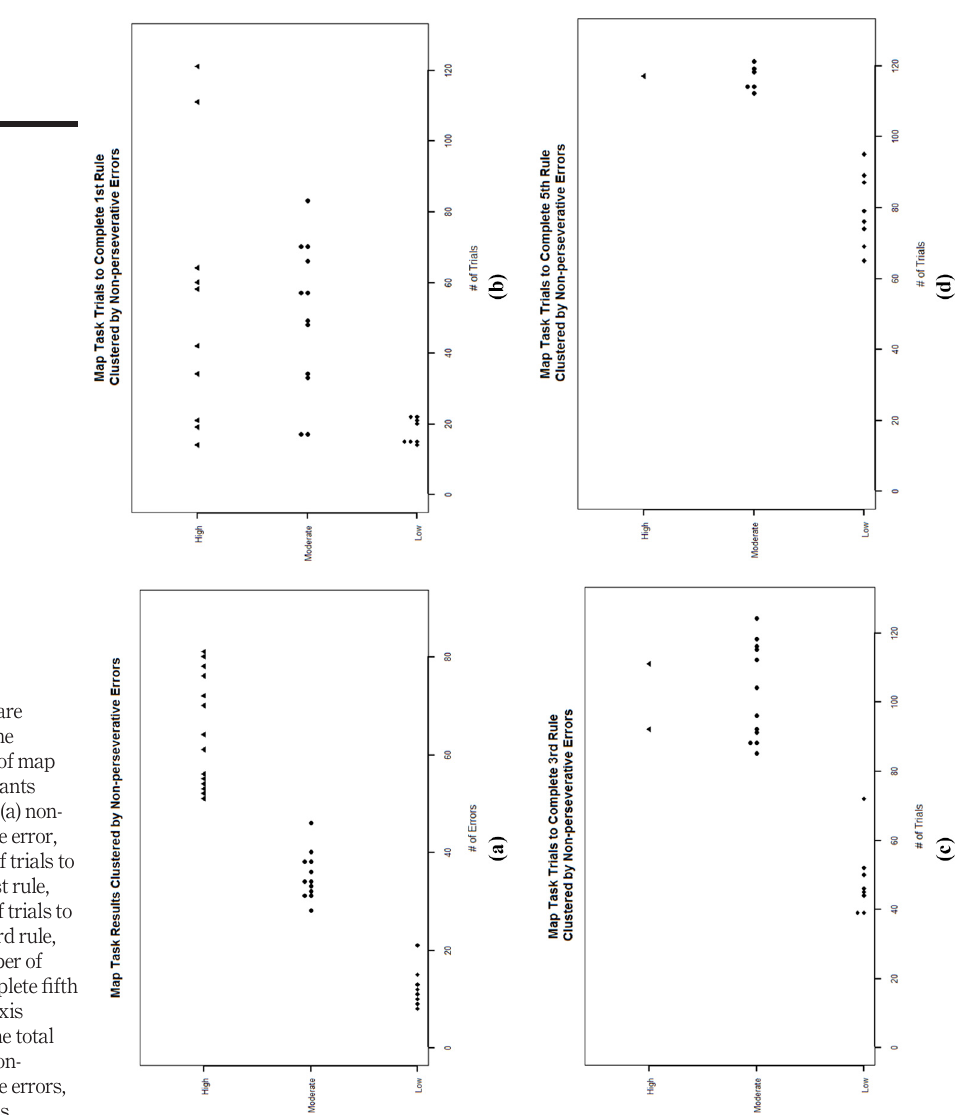
Figure 3. Strip charts are displaying the distribution of map task participants clustered by (a) non- perseverative error, (b) number of trials to complete fi rst rule, (c) number of trials to complete third rule, and (d) number of trials to complete fi fth rule. The x -axis represents the total number of non- perseverative errors, and the y -axis represents the cluster label for a group of